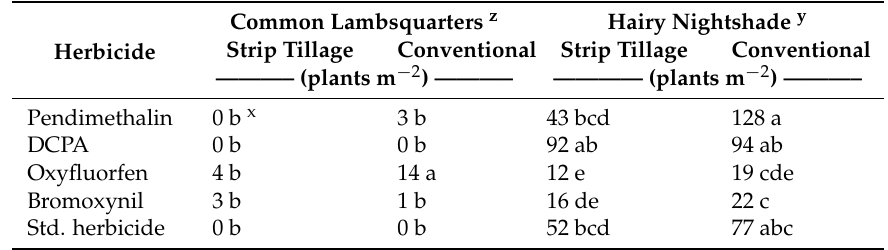
Table 3. Common lambsquarters ( Chenopodium album ) and hairy nightshade ( Solanum physalifolium ) densities as affected by herbicide and tillage averaged over years at Oakes, ND,